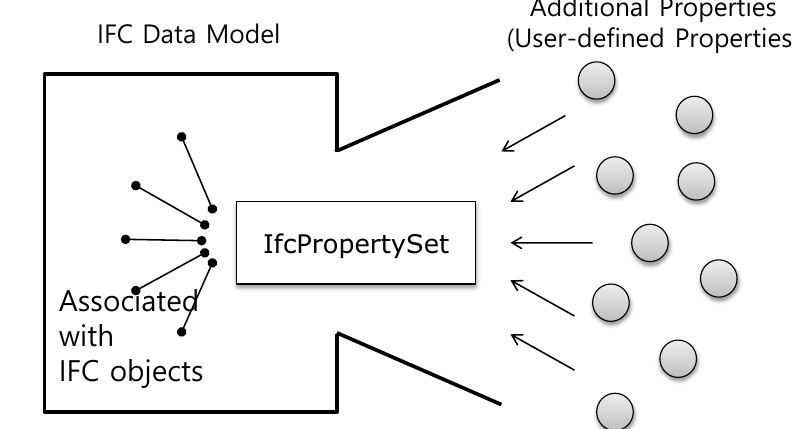
Figure 1. Industry foundation classes (IFC) and sets of properties.